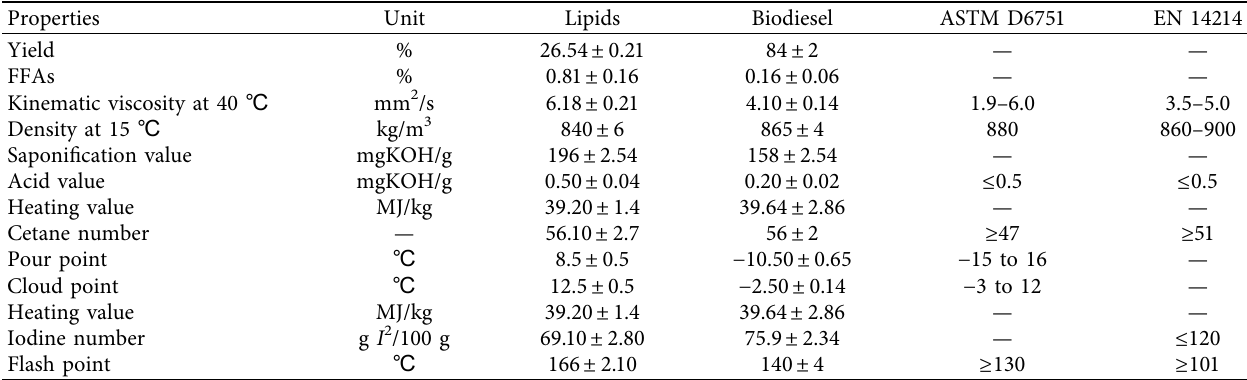
Table 3: Physicochemical properties of ScCO 2 extracted lipids from municipal sewage sludge (MSS) and sewage sludge biodiesel. Properties